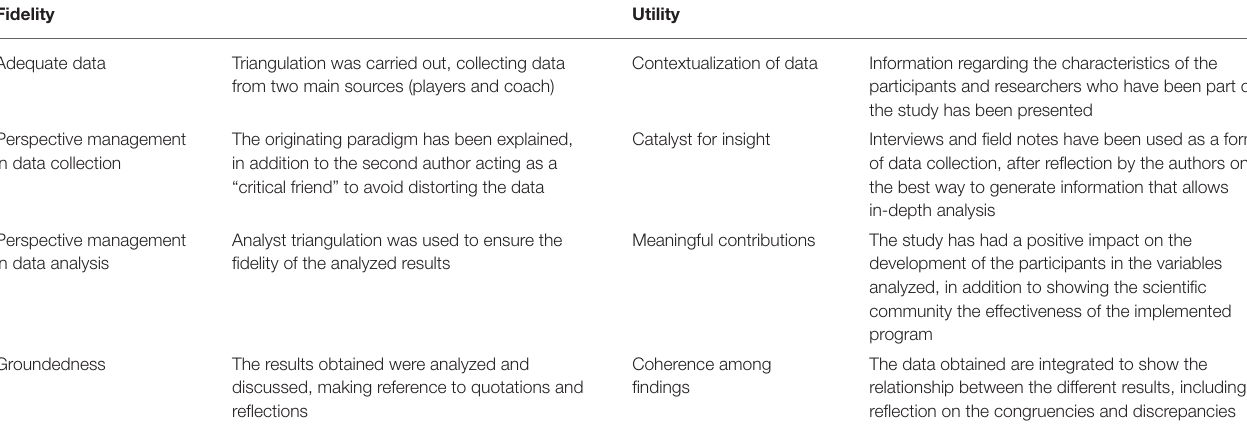
TABLE 4 | Methodological integrity. Fidelity